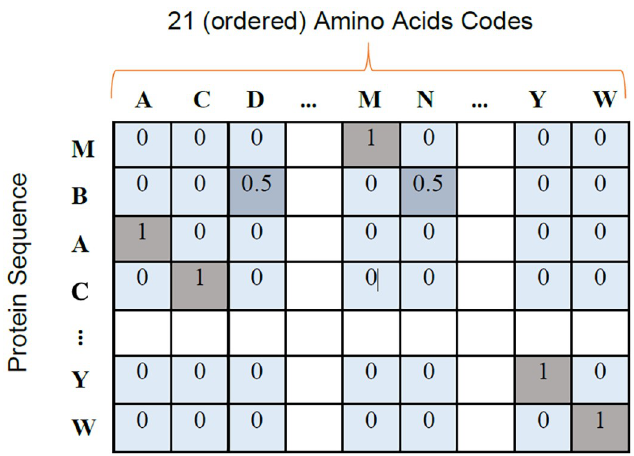
Fig 1. A sequence as a matrix. Representation of a sequence as a matrix (2D array) after encoding the raw amino acid sequence. The x-axis represents invariant 20 positions of amino acids and 1 position for non-amino acids. y-axis represents the sequence with fixed length of at most 1000 amino acids